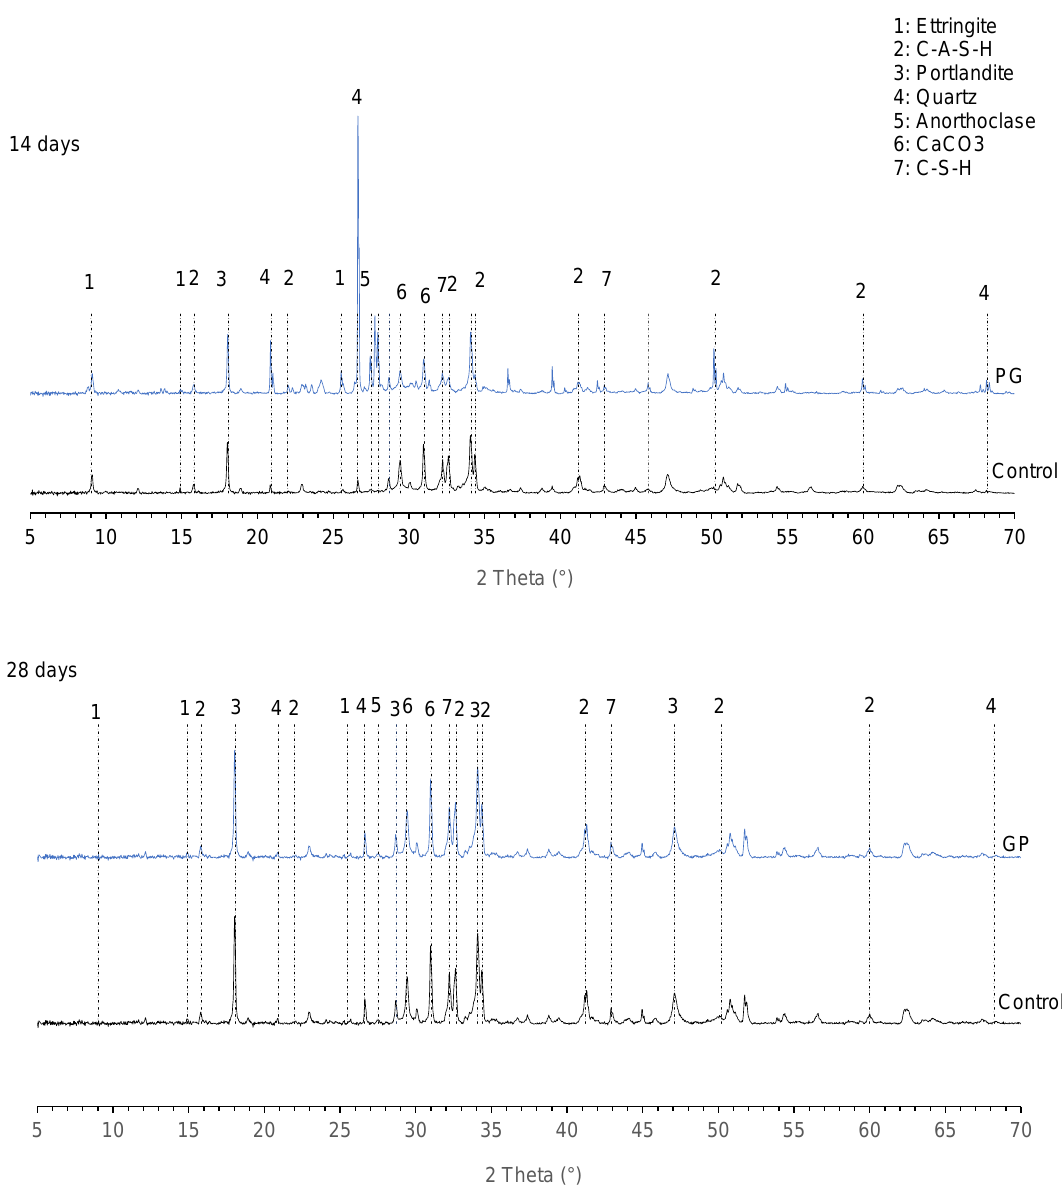
Figure 4. XRD patterns of control and GP pastes at 14 and 28 days (Ett = Ettringite; CH = Portlandite).